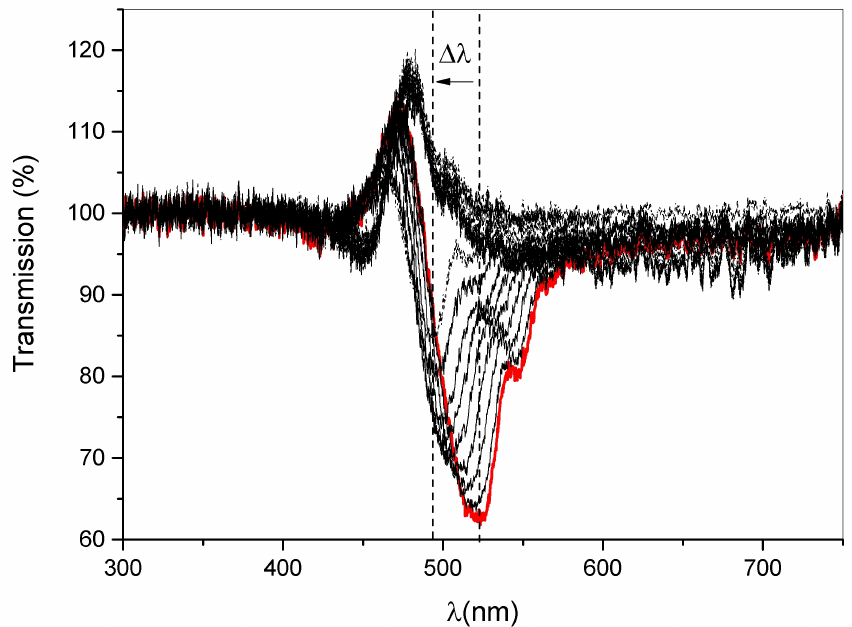
Figure 9. Behaviour of the transmission peak as a function of the wavelength. The reflection notch has a blue shift ∆ λ = 30 nm when a rotation of 0.2 rad is applied to the free-standing film. The red curve represents the start of our measurement.